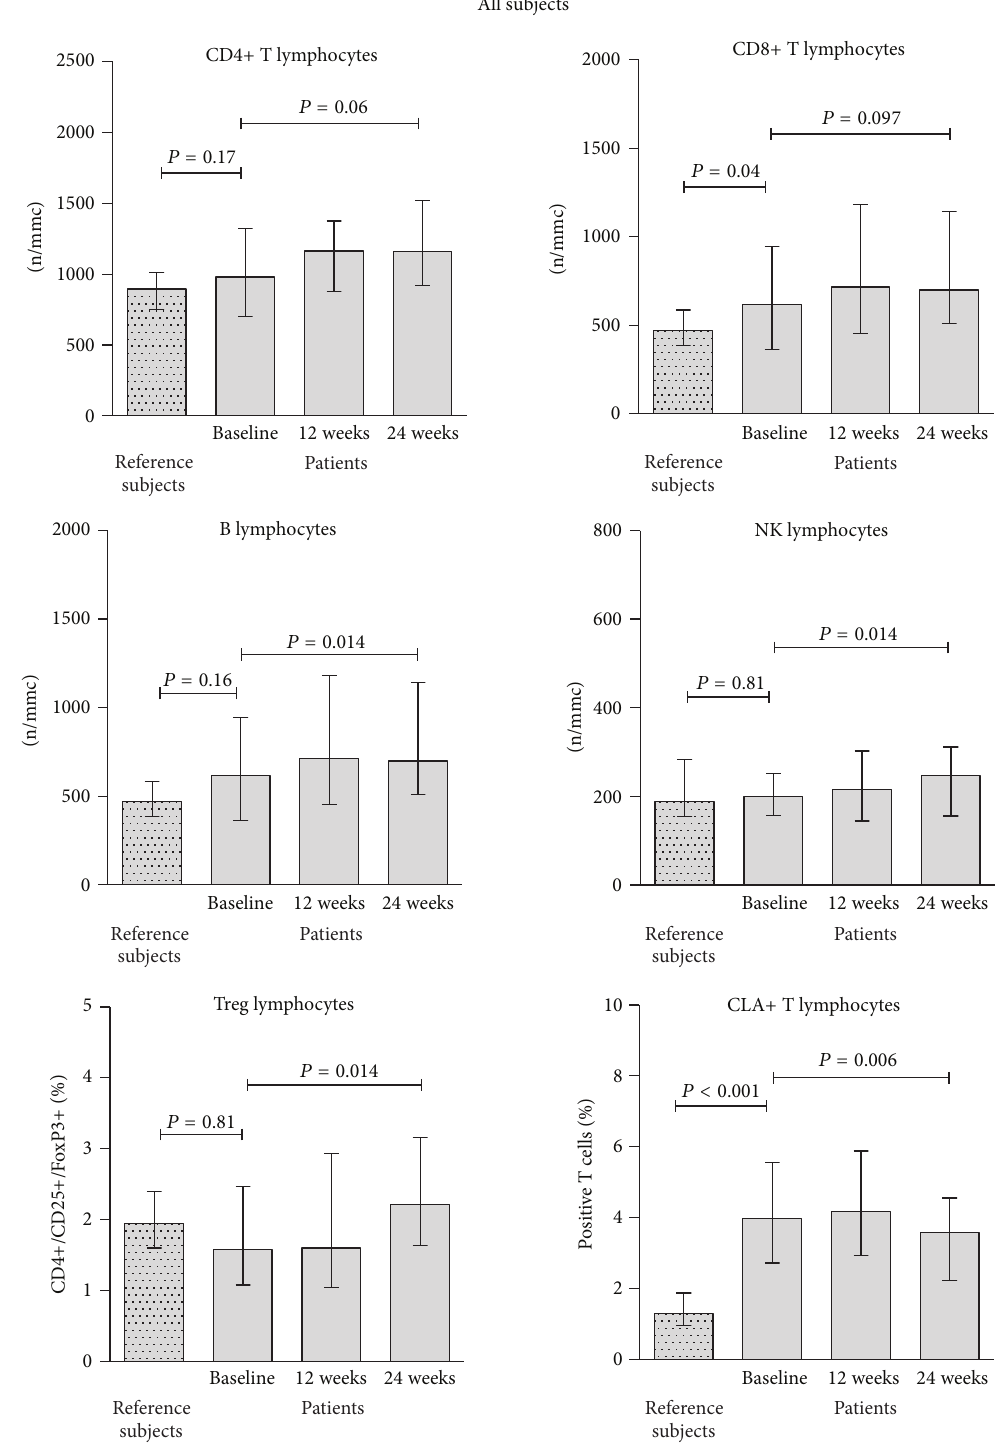
Figure 4: Analysis of lymphocyte subsets (T, B, NK lymphocytes, CD3+CLA+ and Treg cells) in the reference group and in patients before and during anti-TNF- 𝛼 treatment. Baseline measurements in patients and reference subjects were compared by unpaired, nonparametric 𝑡 -test. Measurements before and during therapy were compared by one way ANOVA for repeated measures, nonparametric test. Depicted values are median and interquartile